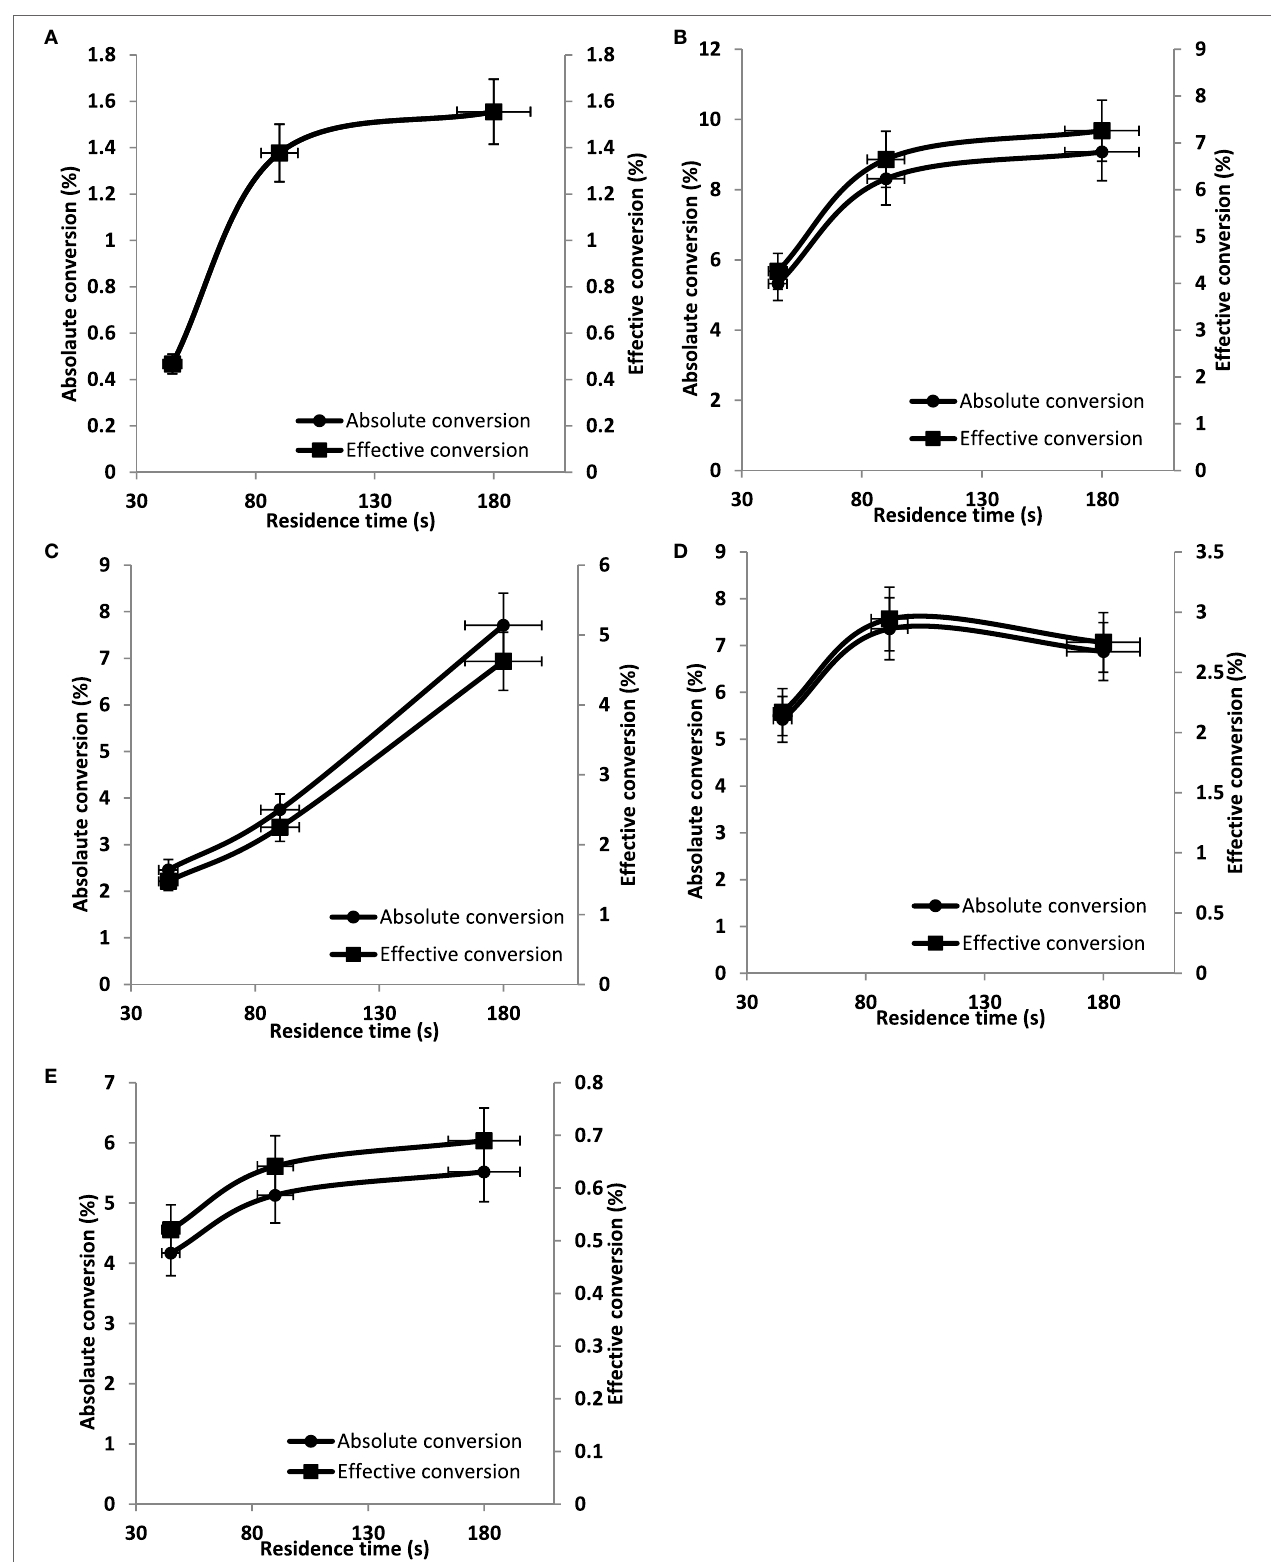
FigUre 12 | Effec tive and absolute conversion of CO 2 to CO as a function of residence time: (a) 100% CO 2 , (B) 80% CO 2 , (c) 60% CO 2 , (D) 40% CO 2 , and (e) 12.5%